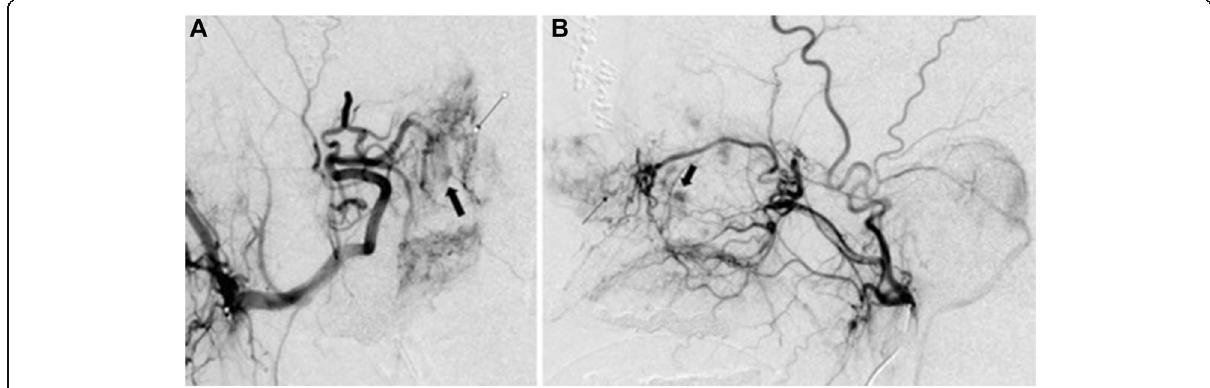
Fig. 3 A and B 45-year-old male who presented with uncontrollable epistaxis. AP and lateral right internal maxillary angiogram show a prominent blush over the right nasal cavity (small black arrow) with areas of prominent pooling of contrast (thick black arrow)